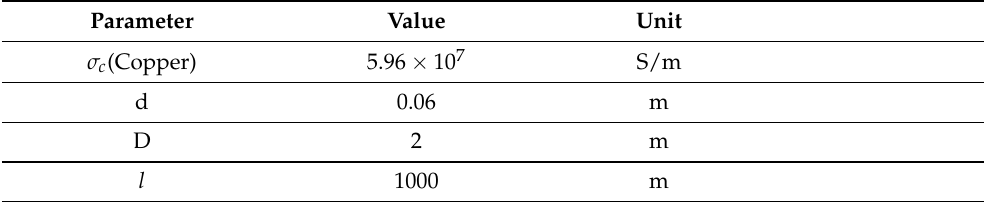
Figure A3. Cable geometry for the demonstration. Table A1. Two-wire cable parameters.